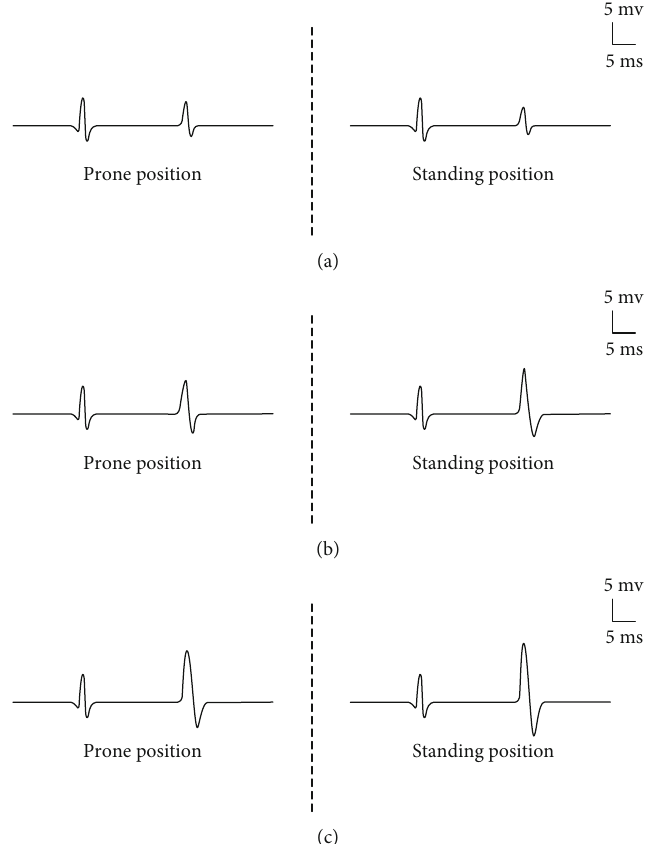
Figure 2: The Hmax in di ff erent positions: (a) healthy subject; (b) the una ff ected side in a stroke patient; (c) the a ff ected side in the same stroke patient (left: prone position; right: standing position). The fi rst wave means the M-wave, and the second wave represents the Hmax. Note the same amplitude changing trend of the Hmax in the both conditions for the